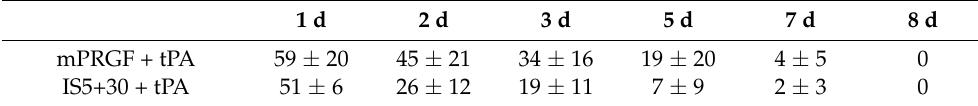
Table 1. Biodegradation percentage of the different PRGF membranes after incubation with tPA for 8 days. The mPRGF and IS5+30 showed no differences in the degradation percentage at any study time.